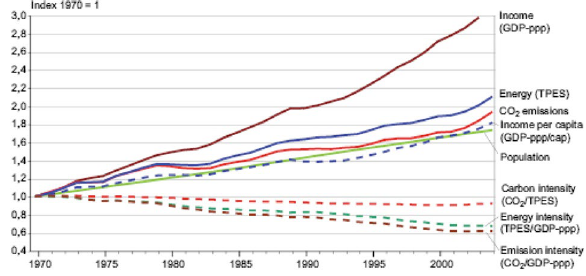
Fig. 1 Global Green House Emissions: ‘Figure shown above illustrates schematically the global greenhouse gas emissions over a life-span of approximately 3 decades from the period